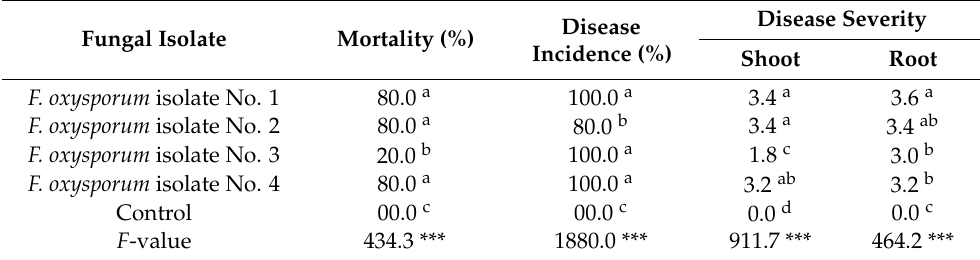
Table 4. Root rot incidence and severity of F. oxysporum isolates on date palm seedlings. Fungal Isolate